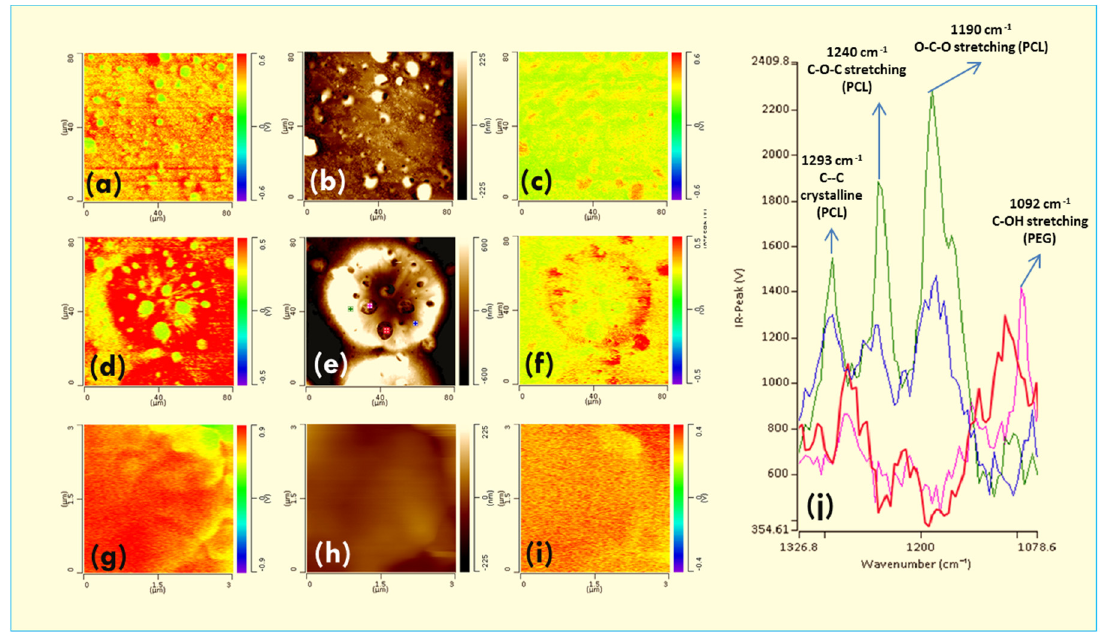
Figure 10. AFM images ( b , e , h ), IR mapping images ( a , d , g ) at 1724 cm − 1 (carbonyl group of PCL), IR mapping images ( c , f , i ) and AFM-IR spectra ( j ) of PCL / PEG (50 / 50) blends isothermal crystallization at 40 °C. Unpublished work.